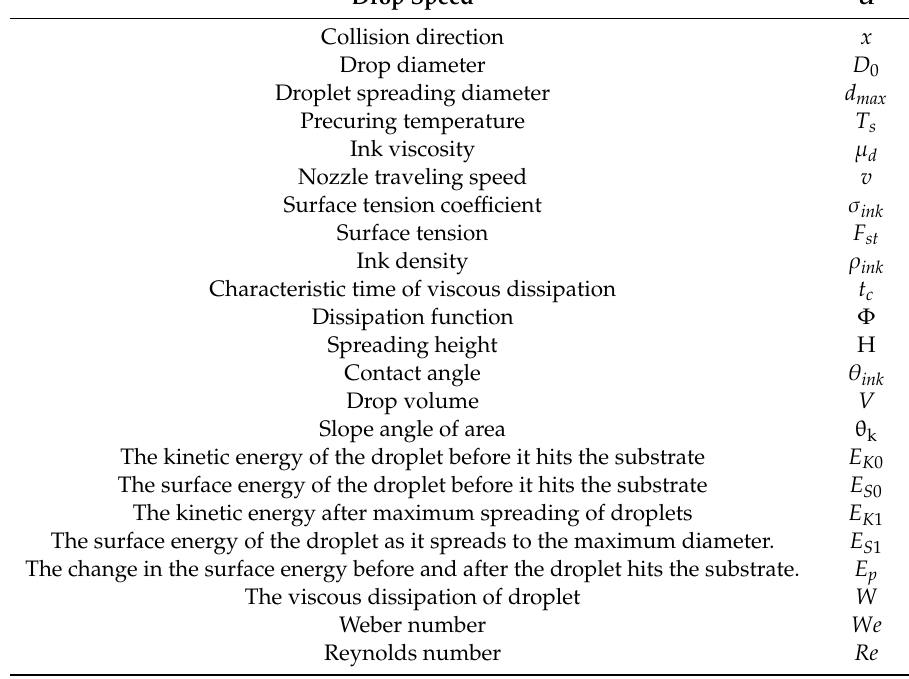
Table 1. Parametric models and